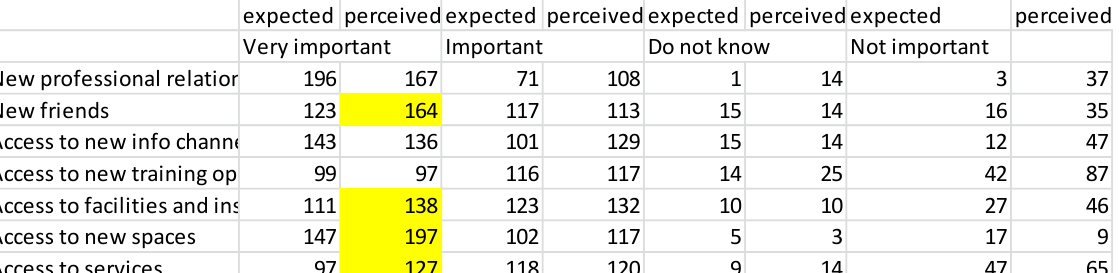
Table 1. The expected and perceived advantages to work in a CS